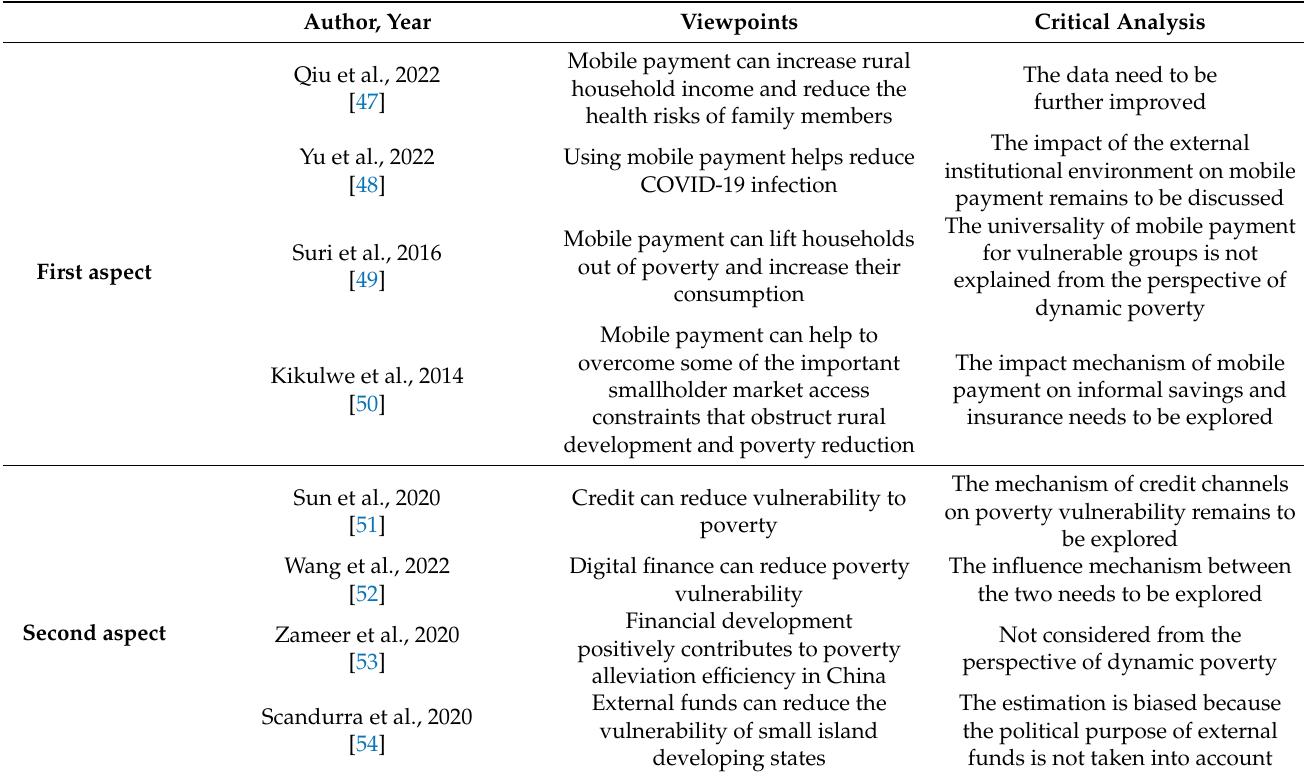
Table 1. Representative viewpoints on the relationship between mobile payment and